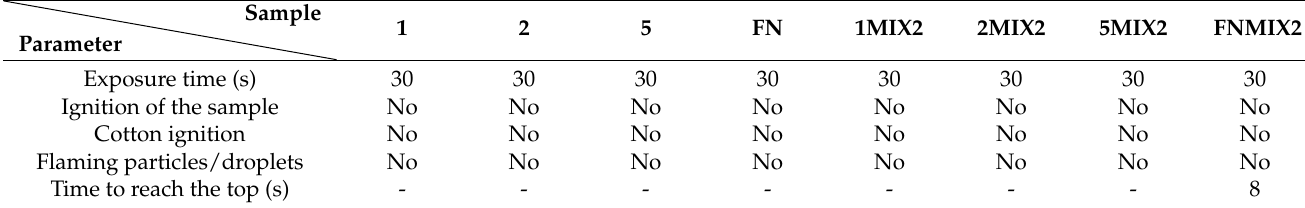
Table 5. Ignitability test